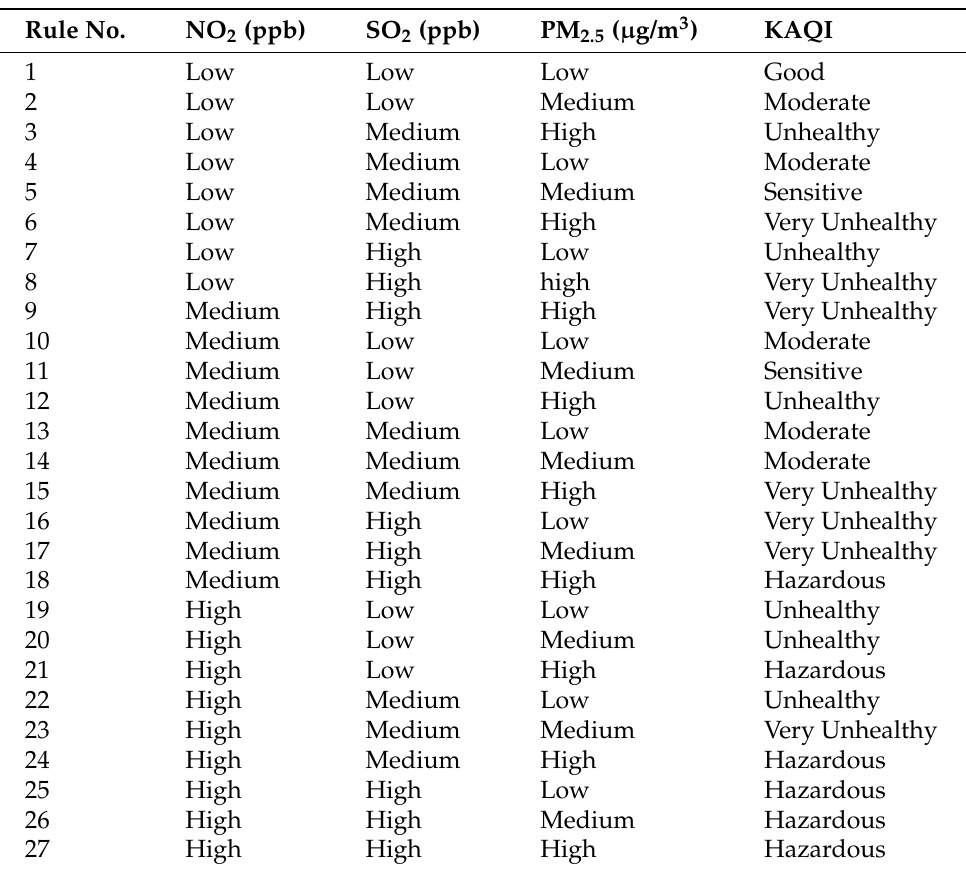
Table 4. FIS Rule base for NO 2 , SO 2 , PM 2.5 .